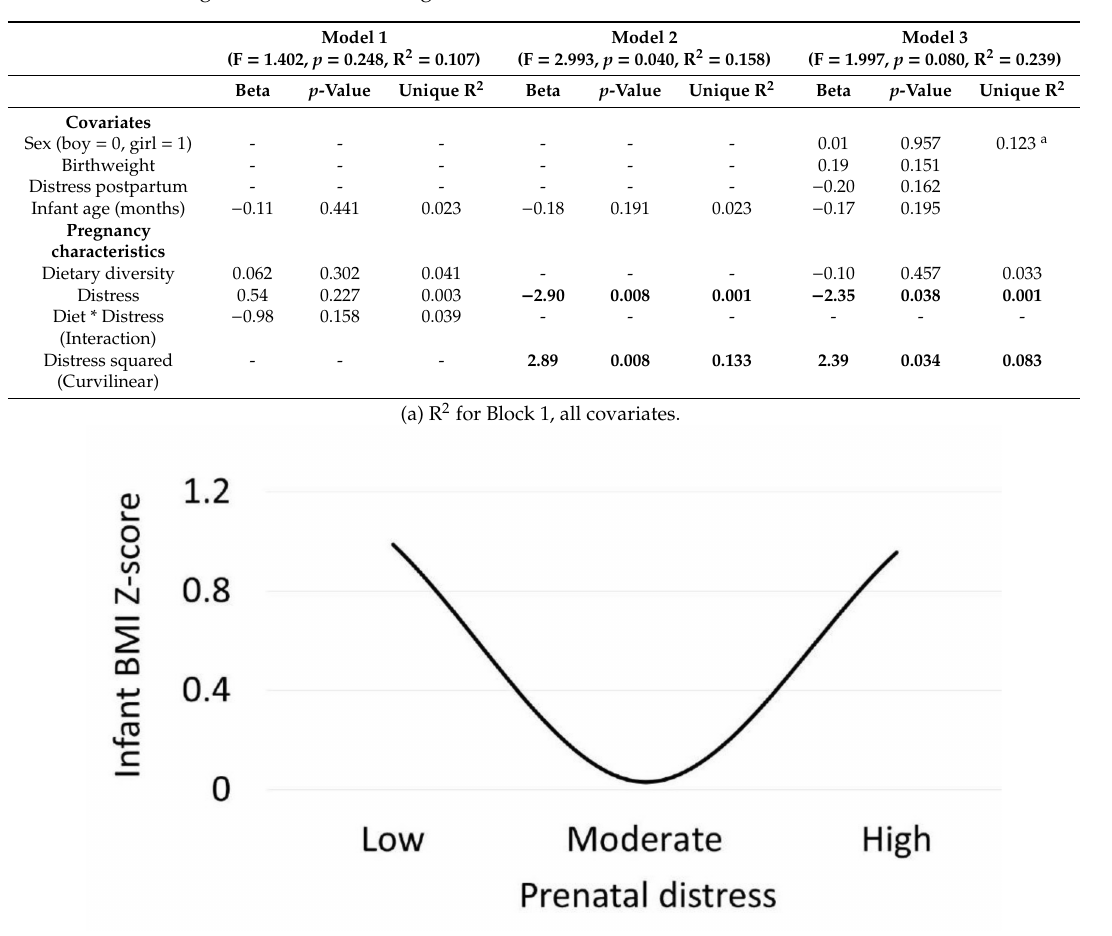
Figure 1. Relationship between prenatal distress and infant body mass index (BMI) Z-scores: Predicted values for BMI Z-scores plotted from results of regression analyses. Values for low, moderate, and high distress represent the 10th, 50th, and 90th percentiles in the current